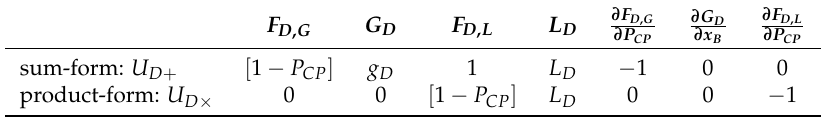
Table 3. Gain and cost terms and their multipliers for sum-form and product-form utilities of the provider. F D , G G D F D ,